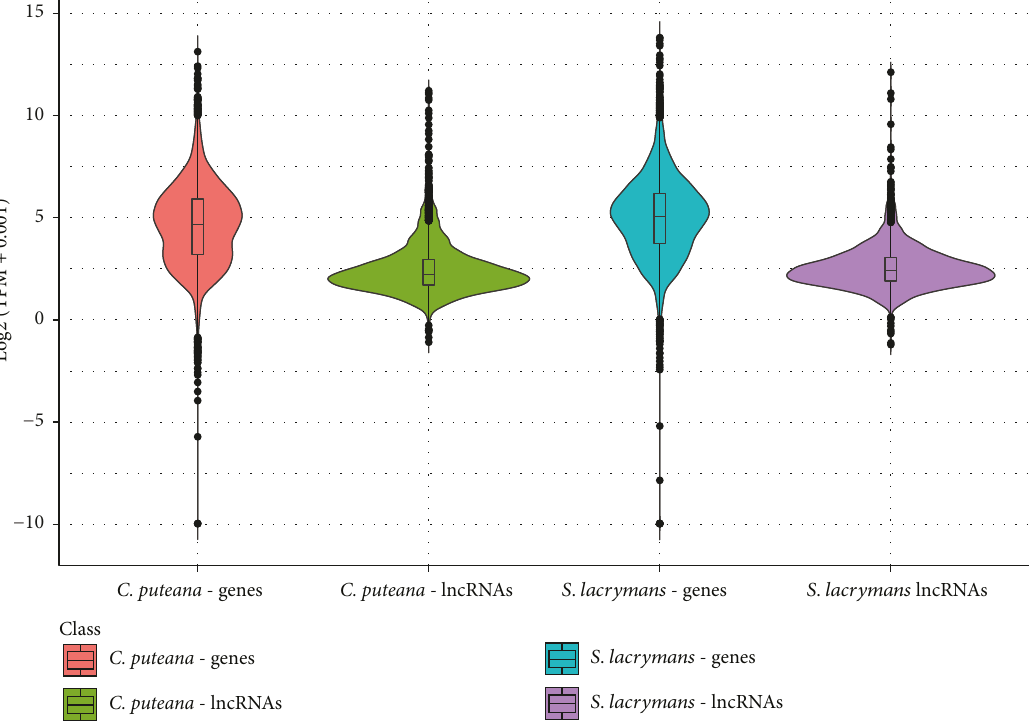
Figure 5: Distribution of transcriptional levels of coding transcripts and lncRNAs of C. puteana and S. lacrymans cultured on SOM medium. Box plots inside the violin plots are presented, showing the median value as a horizontal